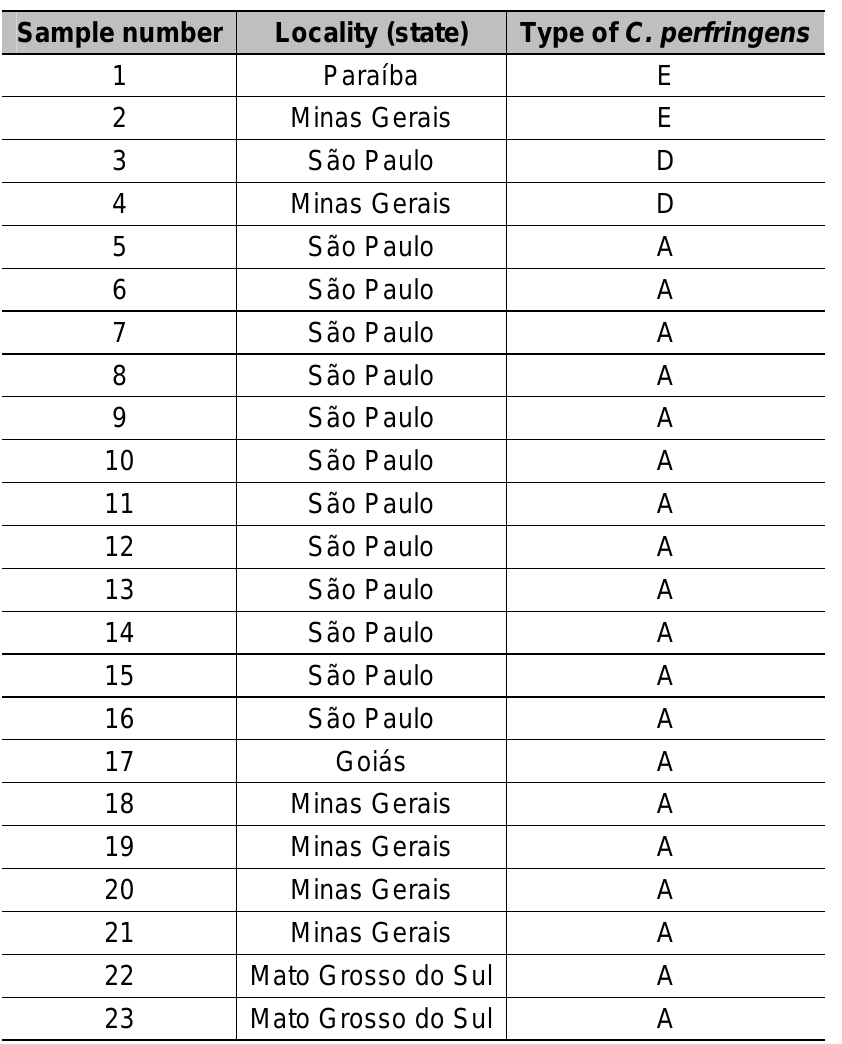
Table 2. Results of C. perfringens strain typing by PCR Sample